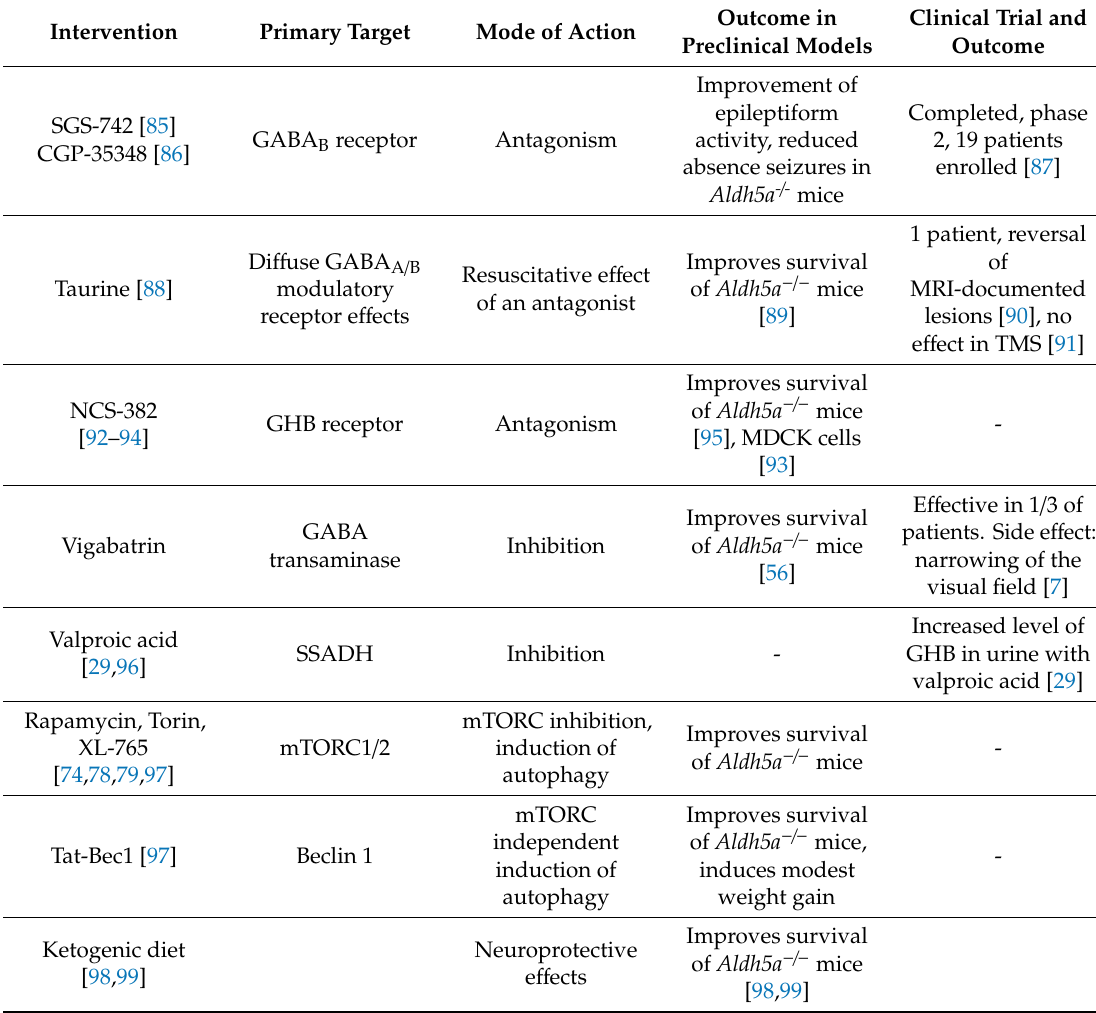
Table 3. Summary of the preclinical treatment concepts and clinical trials that have been carried out or are in progress for